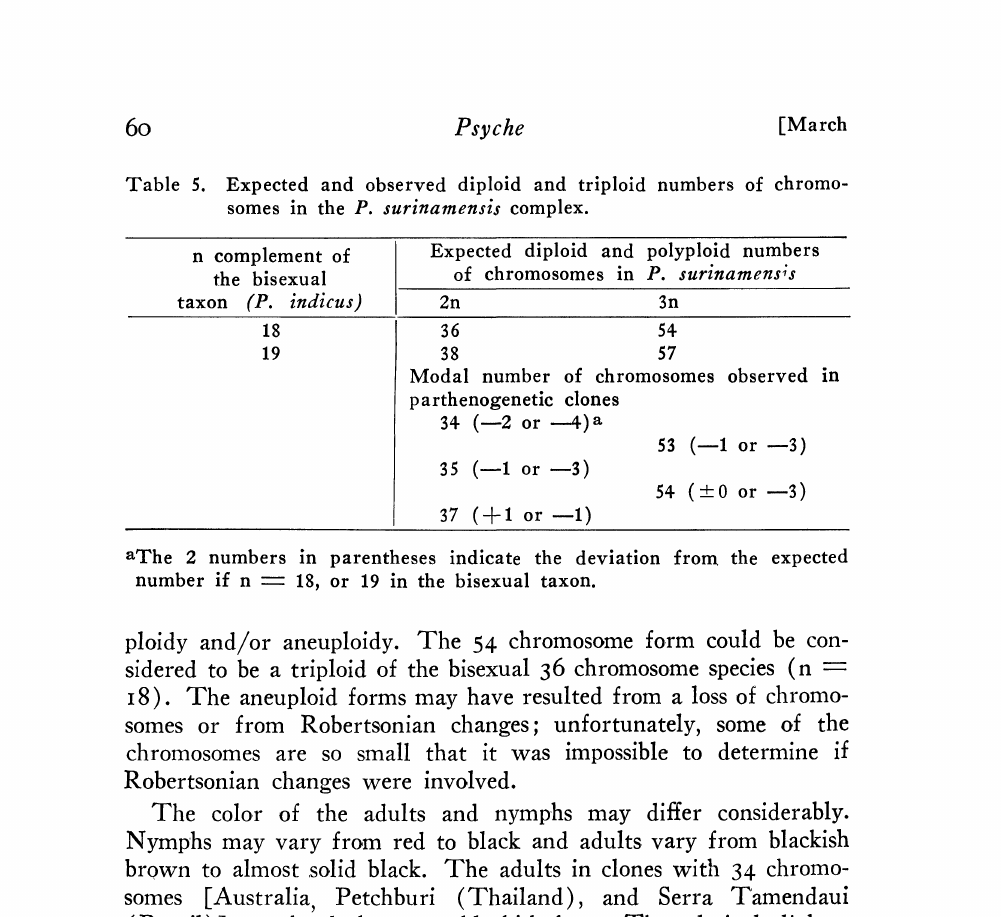
Table 5. Expected and observed diploid and triploid numbers of chromo- somes in the P. surinamensis complex. n complement of the